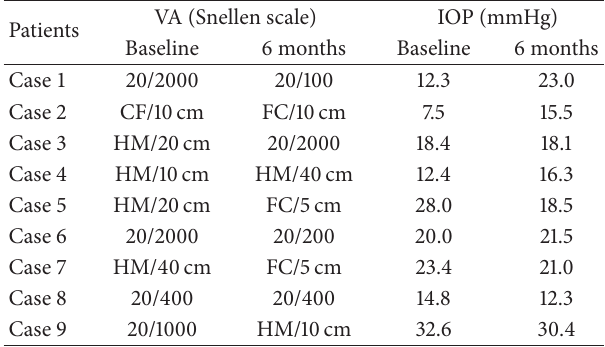
Table 3: The changes of visual level and IOP during the